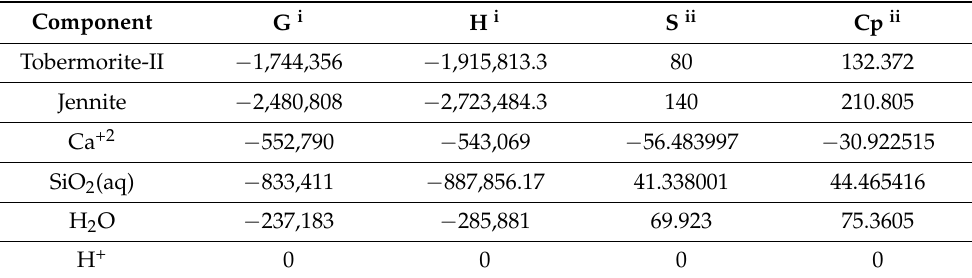
Table 1. Thermodynamic properties of tobermorite-II and jennite as taken from the cemdata07 database [7]. Letters assigned to each end-member are shown in parentheses.